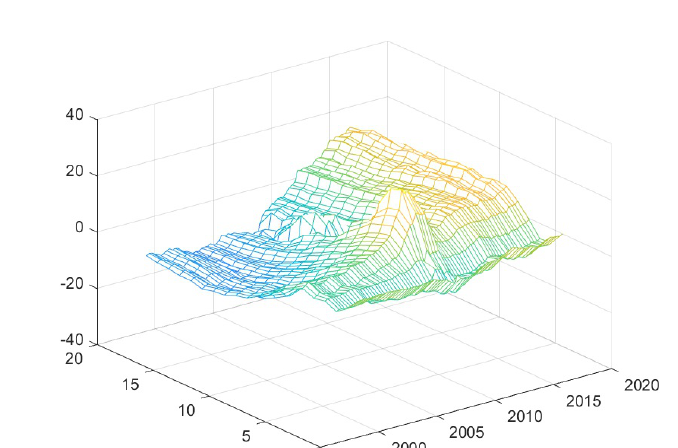
Figure A4. Baseline.